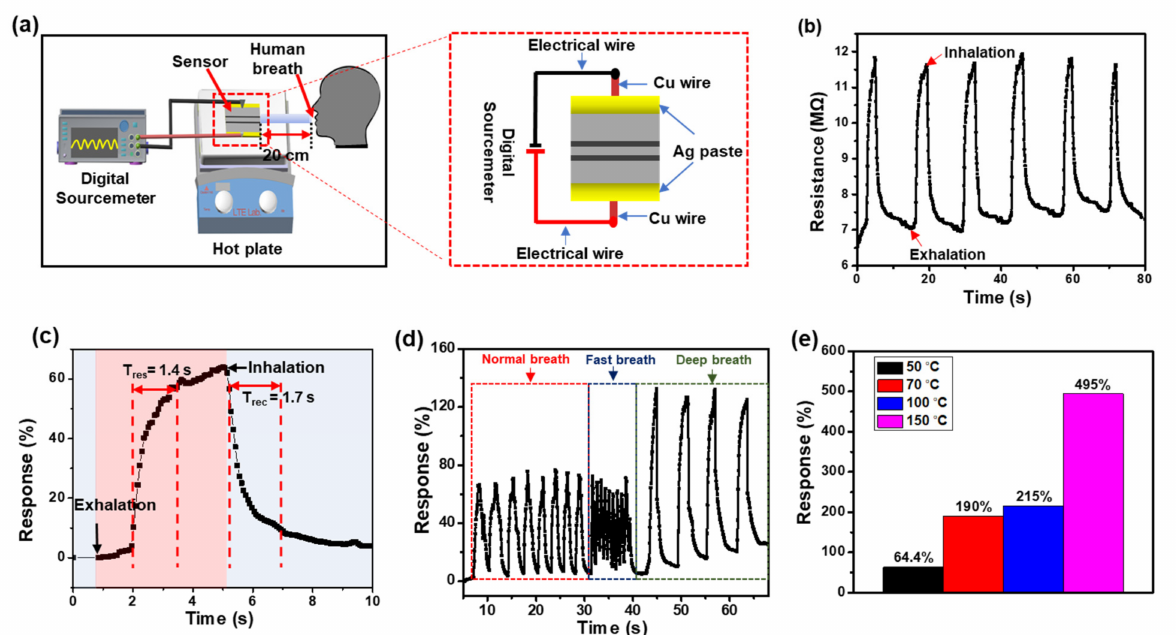
Figure 4. ( a ) Schematic diagram of the experimental setup to test the breath sensing performance of the senor. ( b ) Electrical resistance variation of the Ni/NiO x -based breath sensor to the normal breathing rate at the operating temperature of 50 ◦ C. ( c ) Response and recovery times of the breath sensor to the normal breath rate at 50 ◦ C. ( d ) Response curves of the breath sensor to the different breathing rates at 50 ◦ C. ( e ) Maximum responses of the breath sensor to the normal breath rate at different